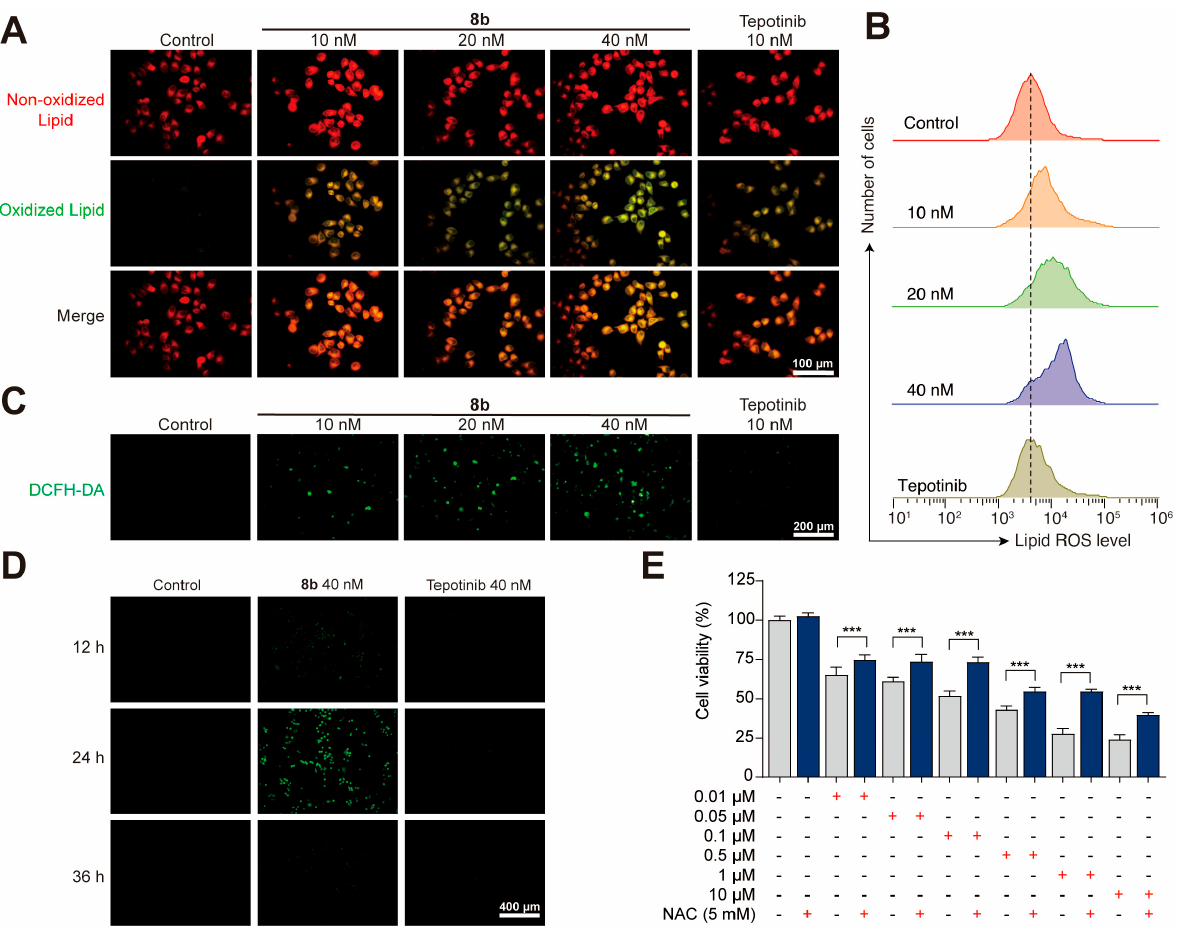
Figure 2. ( A ) Representative images for lipid peroxidation in MHCC97H cells using a C11-BODIPY- 581/591 probe after incubation with compound 8b (10, 20 and 40 nM) or tepotinib 7 (10 nM) for